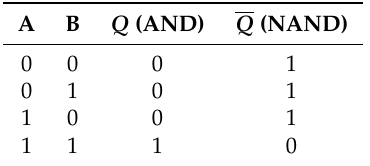
Figure 6. NV-AND / NV-NAND structure. Table 2. Truth table of